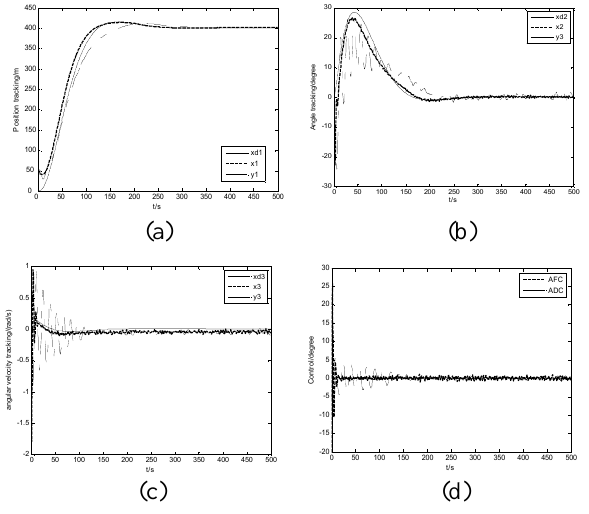
Fig. 7. Comparison of the two methods in case I. (a) sway displacement (b) yaw angle (c) yaw rate (d) control rudder